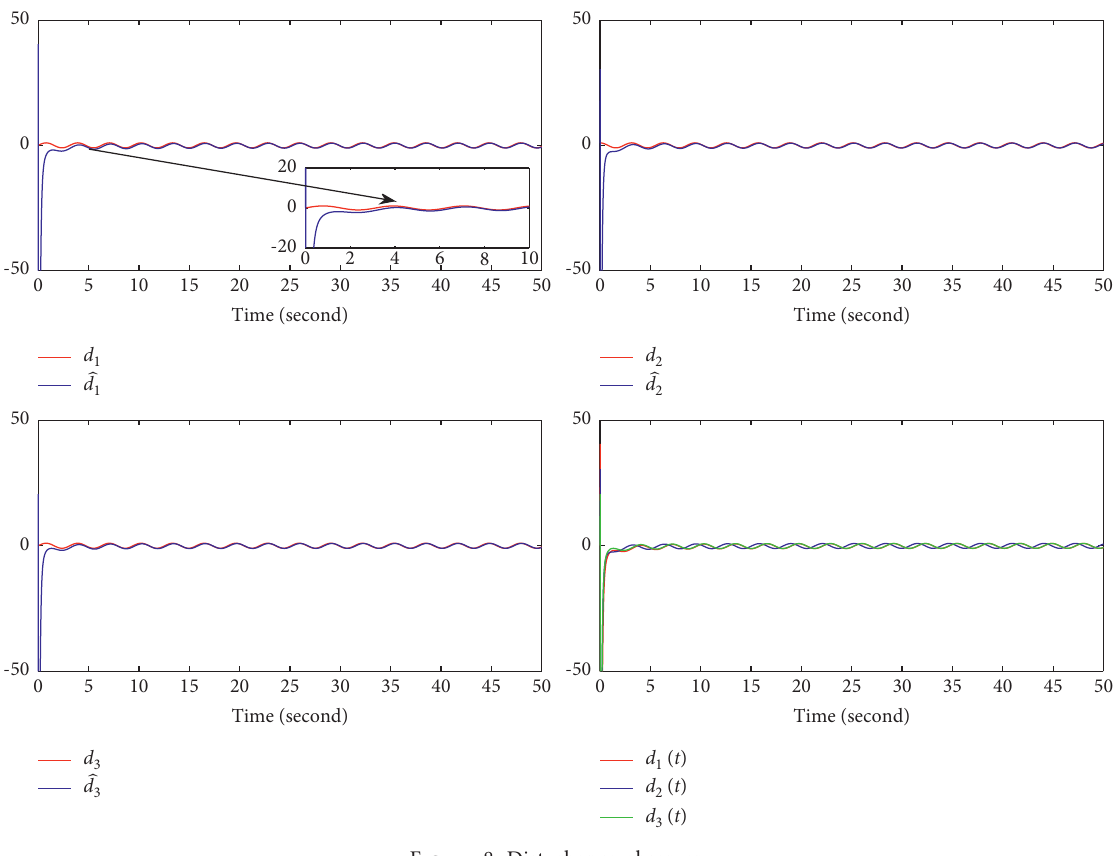
Figure 8: Disturbance